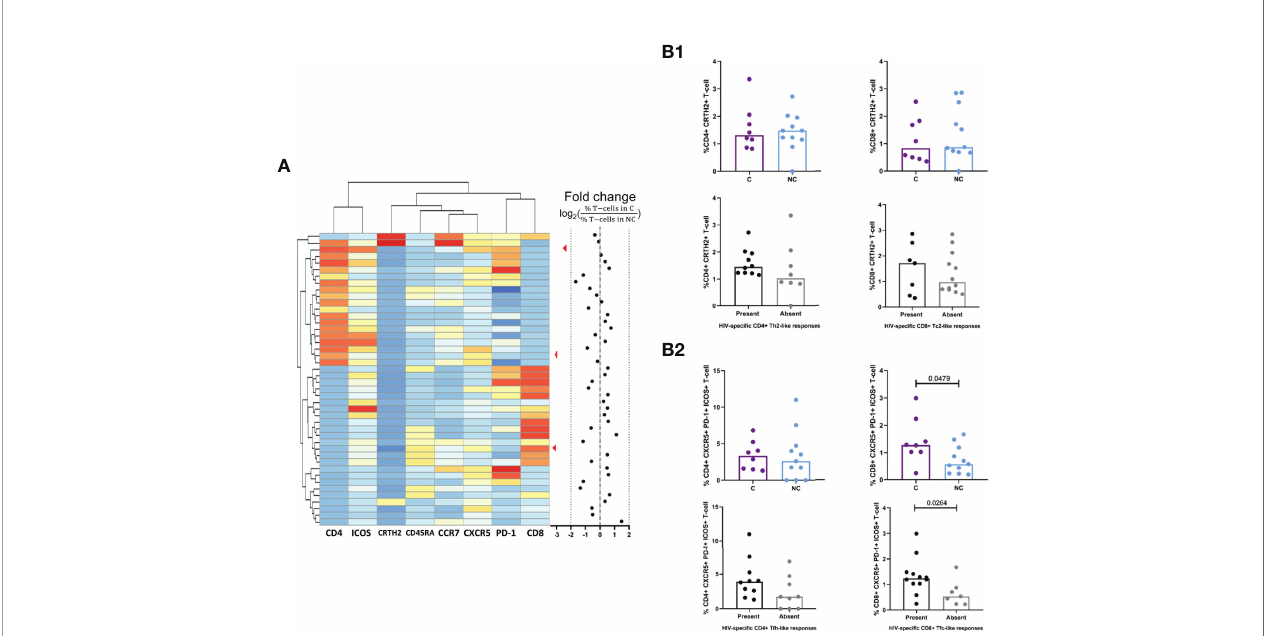
FIGURE 4 | Comparison of CD4+ Th2 and Tfh and CDS+ Tc2 and Tfc subpopulations between controllers and non controllers. (A) Unsupervised clustering of CD4+ and CD8+ T-cell population based on the expression of Th2/Tc2 marker (CRTH2). Tfh/Tfc markers (CXCRS, PD-1, ICOS) and memory phenotype markers (CCR7, CD45RA) by FlowSOM. Results are expressed as a fold change between the presence of the clusters in HIV+ controllers (C, purple) compared to HIV+ non-controllers (NC, light blue). (Bl) Comparison of the percentage of CRTH2+ CD4+ Th2-cells (left) and CD8+ Tc2 cells (right) stratifying by HIV control status (above) or the presence or absence of HIV-specif ic Th2/Tc2 responses (below). (B2) Comparison of the percentage of CXCRS+PD-l+ICOS+ CD4+ Tfh-cells (left) and CD8+ Tfc cells (right) stratifying by HIV control status (above) and the presence or absence of HIV-speci fi c Tfh/Tfc-like cytokine responses by boosted fl ow responses